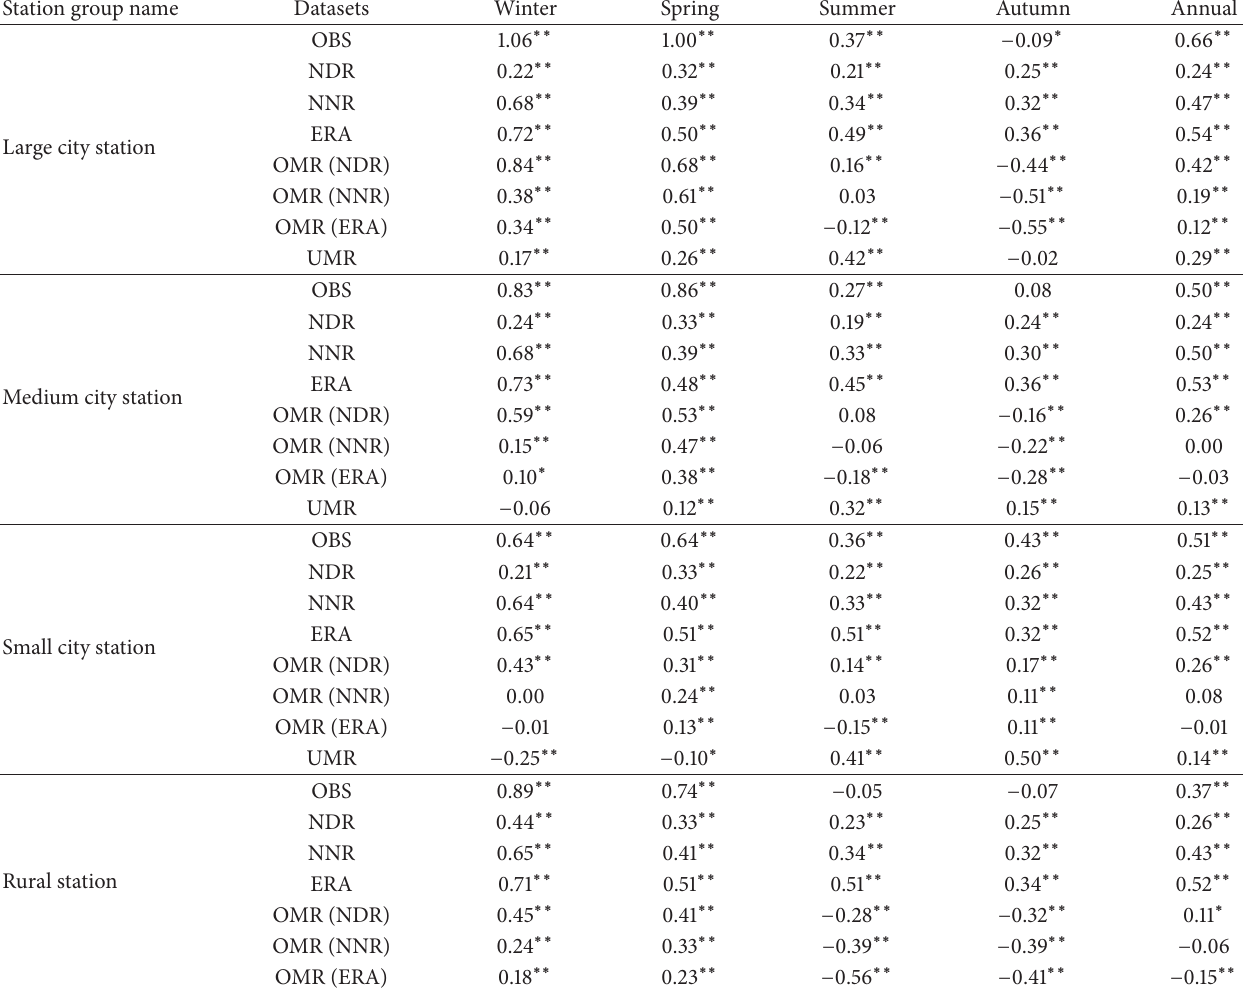
Table 5: Annual and seasonal mean temperature trends from station observation and three reanalysis datasets. Shown are the differences between the observations and the reanalysis datasets (OMR) as well as the differences between the urban and rural sites (UMR) for the different station groups from 1979 to 2009 ( ∘ Cdecade − 1 ). Statistical significance is 0.05 (single asterisk) and 0.01 (double